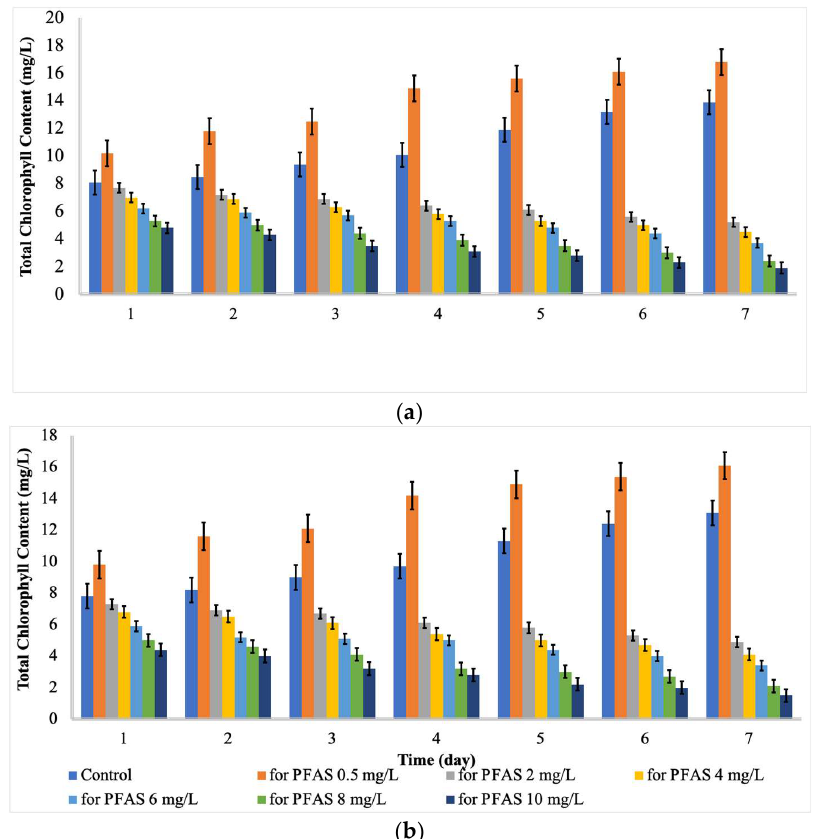
Figure 2. Total Chlorophyll (mg L − 1 ) at different concentrations of PFAS (mean ± error, n = 3); ( a ) for Chlorella vulgaris and ( b ) for Scenedesmus obliquus